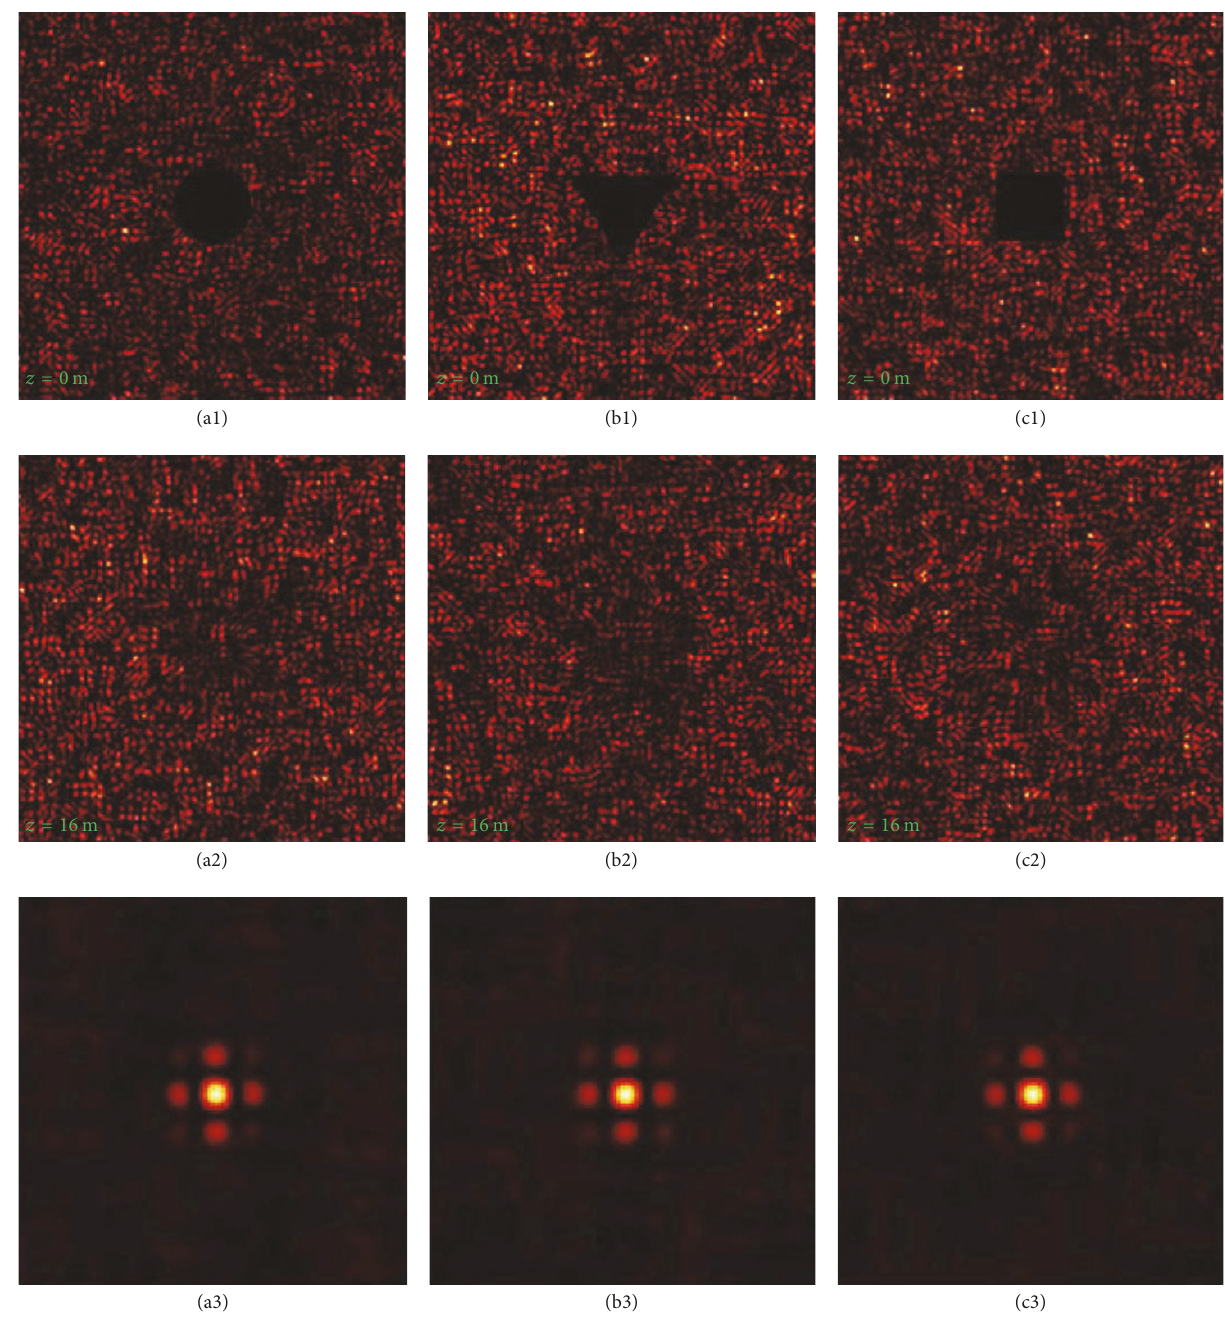
Figure 5: The simulation of speckle pattern and corresponding to the autocorrelation for different shape of obstruction with 𝛿 = 6 mm; 𝑛 = 1 . The shape of the obstruction is circle (a1), equilateral triangle (b1) and square (c1). The first row denotes the speckle pattern in the source plane, the second row denotes the speckle pattern in the plane of 𝑧 = 16 m, and the third row denotes the autocorrelation of the speckle pattern in the second